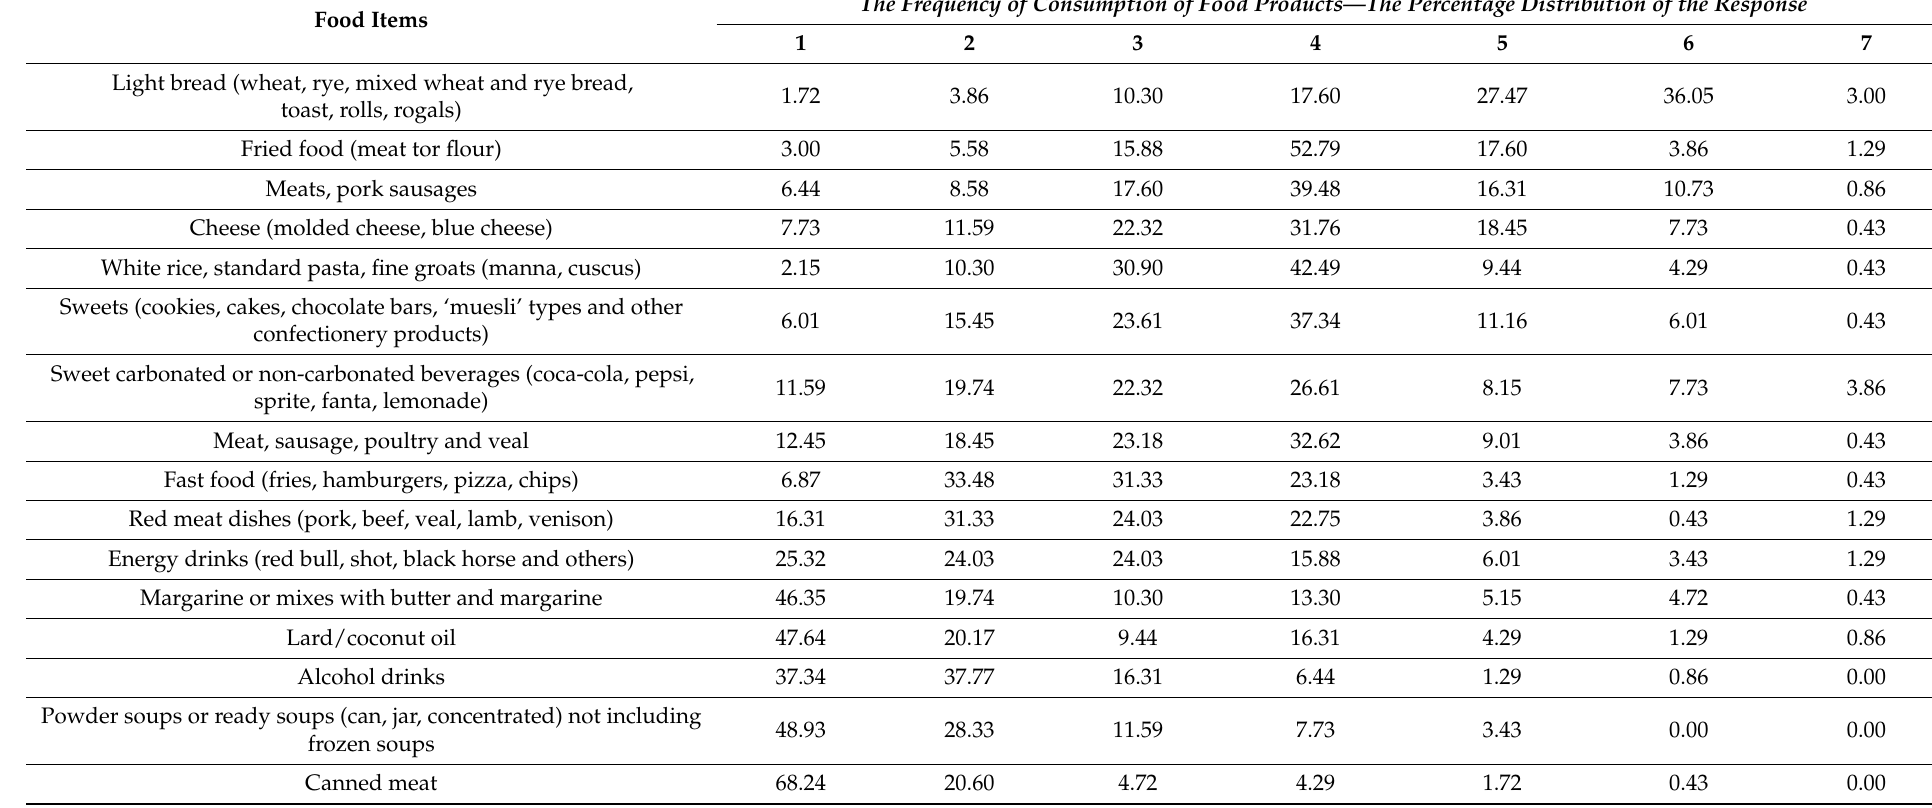
Table A3. The frequency of food items consumption negatively influences the brain function—the distribution of responses. Food